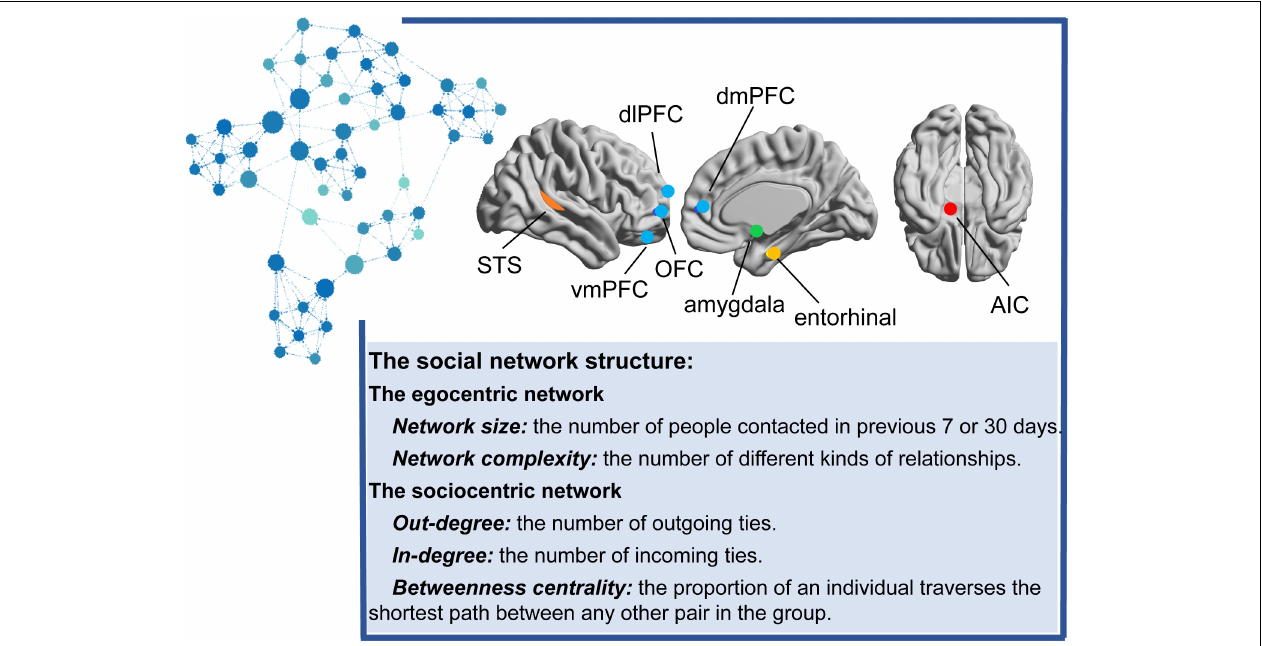
FIGURE 1 | The main brain regions correlated with the social network structure. Different colored dots in the brain indicate different brain structures. Blue nodes indicate the mentalizing network, including the vmPFC (ventromedial prefrontal cortex), OFC (orbitofrontal cortex), dlPFC (dorsolateral prefrontal cortex) and dmPFC (dorsomedial prefrontal cortex); the orange dots indicate the mirror network (superior temporal sulcus, STS); the green dot indicates the amygdala; the yellow dot indicates the entorhinal cortex; and the red dot indicates the AIC (anterior insular cortex). Representative graph of the sociocentric network organized for approximately 52 college students. Each node represents one person. Lines between nodes denote relationships. The node color and size indicate the degree centrality (the sum of the in-degree and out-degree ties). Larger nodes in dark blue indicate more outgoing ties and incoming ties, and smaller nodes in light blue indicate fewer outgoing ties and incoming ties. According to the review, the social network size or complexity is positively correlated with the structure and activation of amygdala, the mentalizing network, the mirror network, entorhinal cortex and AIC. The limited research on the sociocentric network only emphasized the association between the degree/betweenness centrality and amygdala or the mentalizing